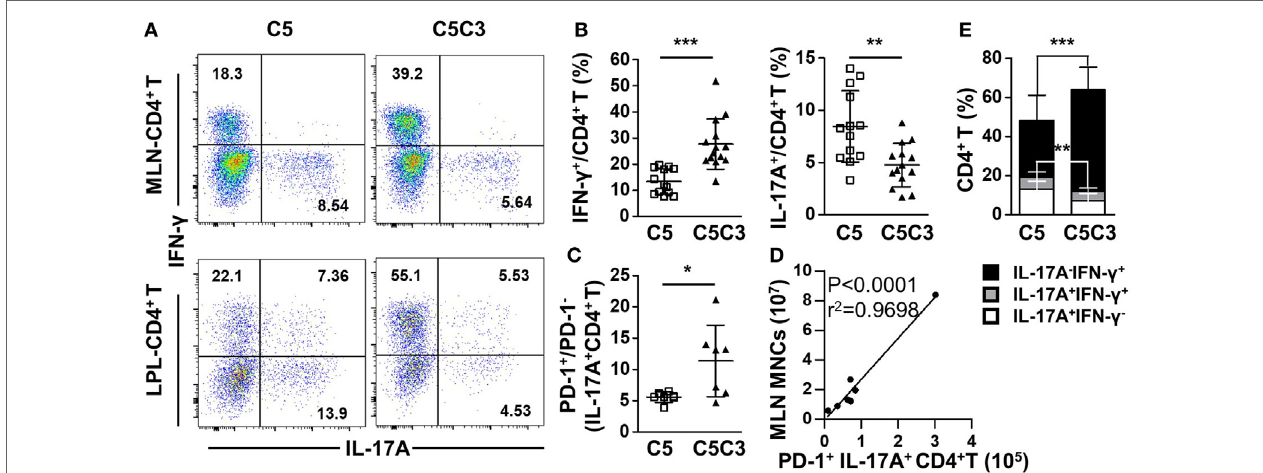
FigUre 6 | Effects of CXC chemokine receptor 3 (CXCR3) deletion on pro-inflammatory factors in colon of CD25 − / − mice. The phenotypes of T cell subsets in the CD25 − / − and CD25 − / − CXCR3 − / − mice were analyzed with flow cytometry. (a) Representative flow cytometry dot plots of mesenteric lymph node (MLN) and colon lamina propria lymphocytes (LPL) CD4 + T cells stained for intracellular interferon (IFN)- γ and interleukin (IL)-17A. (B) Frequency of IFN- γ + and IL-17A + CD4 + T cells in the MLN from CD25 − / − mice ( N = 13) and CD25 − / − CXCR3 − / − mice ( N = 14). (c) PD-1 + /PD-1 − ratio in IL-17A-producing CD4 + T cells in the MLN, compared between CD25 − / − mice ( N = 6) and CD25 − / − CXCR3 − / − mice ( N = 7). (D) The correlation analysis between MLN mononuclear cells (MNCs) and colonic PD-1 + IFN- γ + CD4 + T cells from CD25 − / − CXCR3 − / − mice ( N = 7). (e) Percentages of colon LPL CD4 + T cells expressing IFN- γ + and/or IL-17A + , compared between CD25 − / −